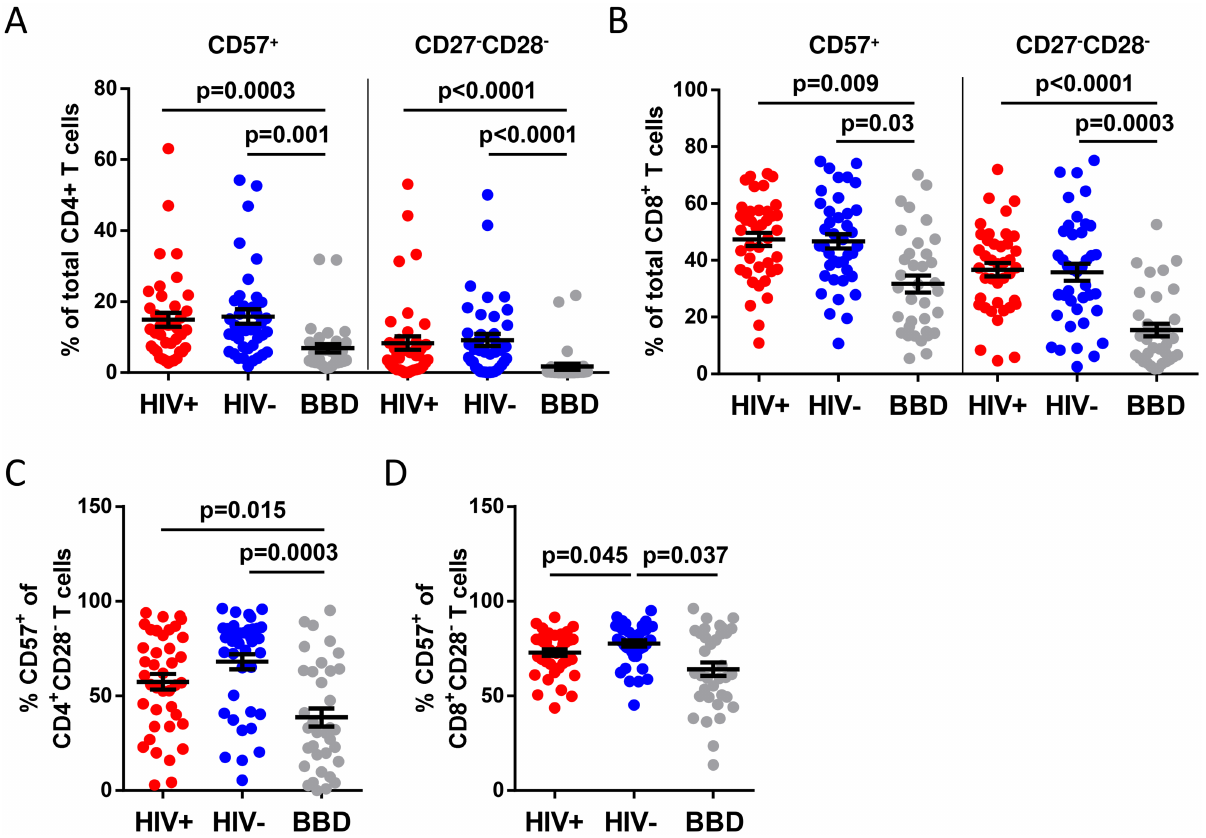
Fig 2. Terminally differentiated CD4 and CD8 T cells in HIV-positive and HIV-negative COBRA participants, and blood bank donors. (a) The percentage of CD57 + and CD27 − CD28 − T cells within the CD4 + T cell population. (b) The percentageof CD57 + and CD27 − CD28 − T cells within the CD8 + T cell population.(c) The percentage of CD57 + cells in the CD4 + CD28 − and (d) CD8 + CD28 − cell population.Significance was assessed with multivariable linear regression,corrected for age and gender. HIV+, HIV-positive; HIV-, HIV- negative; BBD, blood bank donors.